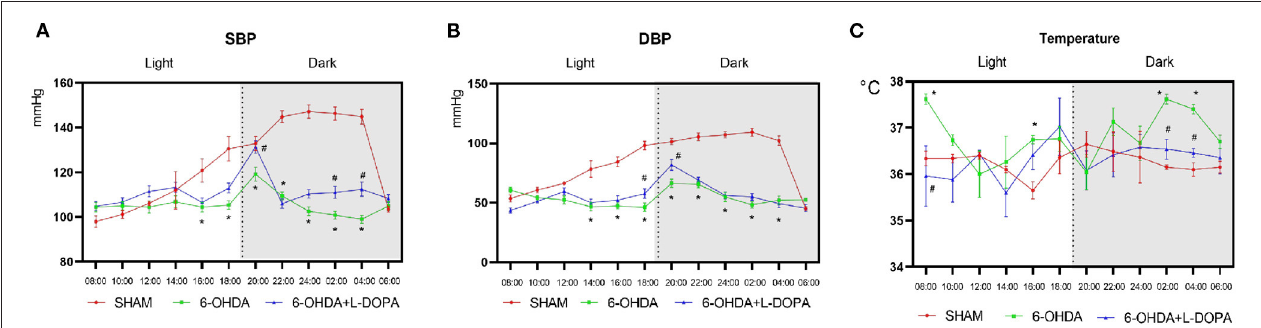
FIGURE 3 | The measurement of BP and temperature. The BP and temperature were measured every 2h since 8:00 on the 22nd day. The measurement of circadian rhythm-related parameters: (A) The curve of the systolic blood pressure (SBP); (B) The curve of the diastolic blood pressure (DBP); (C) The curve of the temperature. * p < 0.05, sham group vs. 6-OHDA-lesioned group; # p < 0.05, 6-OHDA-lesioned group vs. 6-OHDA + L-dopa group. n = 18–24 for each group.